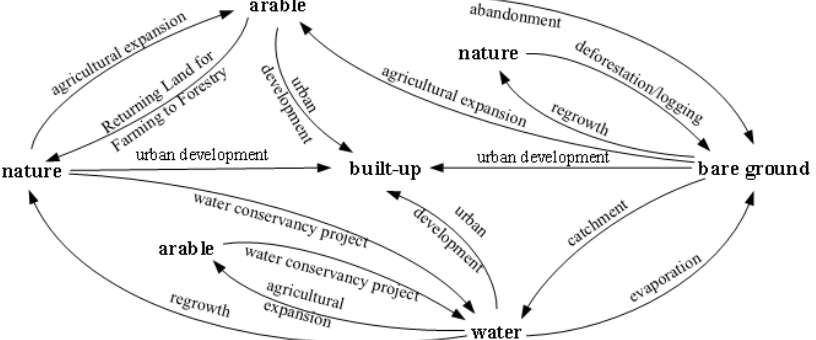
Figure 3. Possible land use trajectories. Nature in the middle right part and the left part of the figure has the same mean.